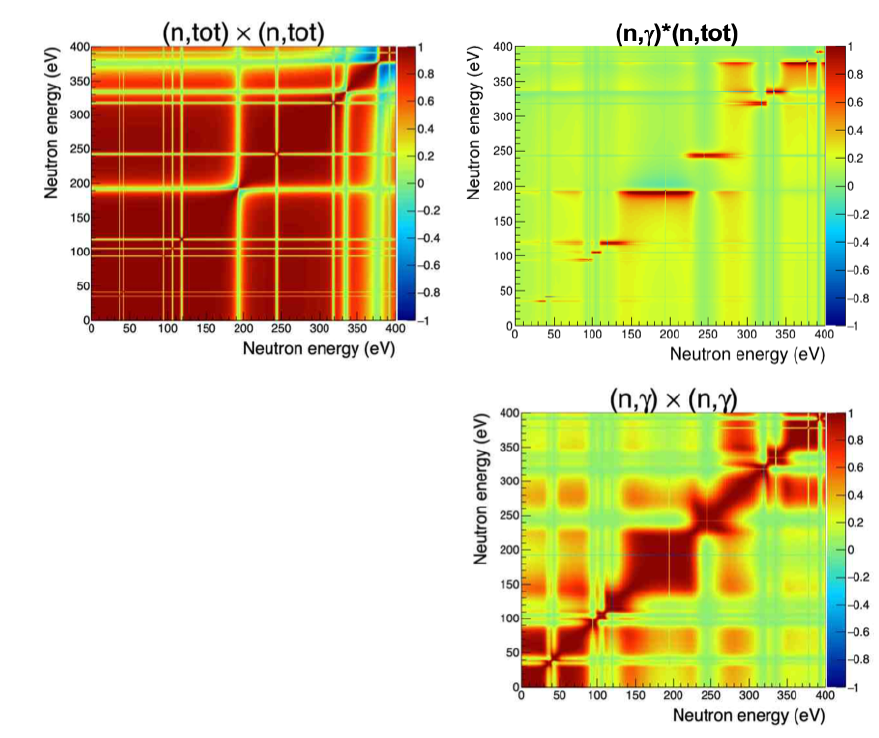
Figure 5. Correlation matrices for n + 93 Nb total and (n, γ ) cross